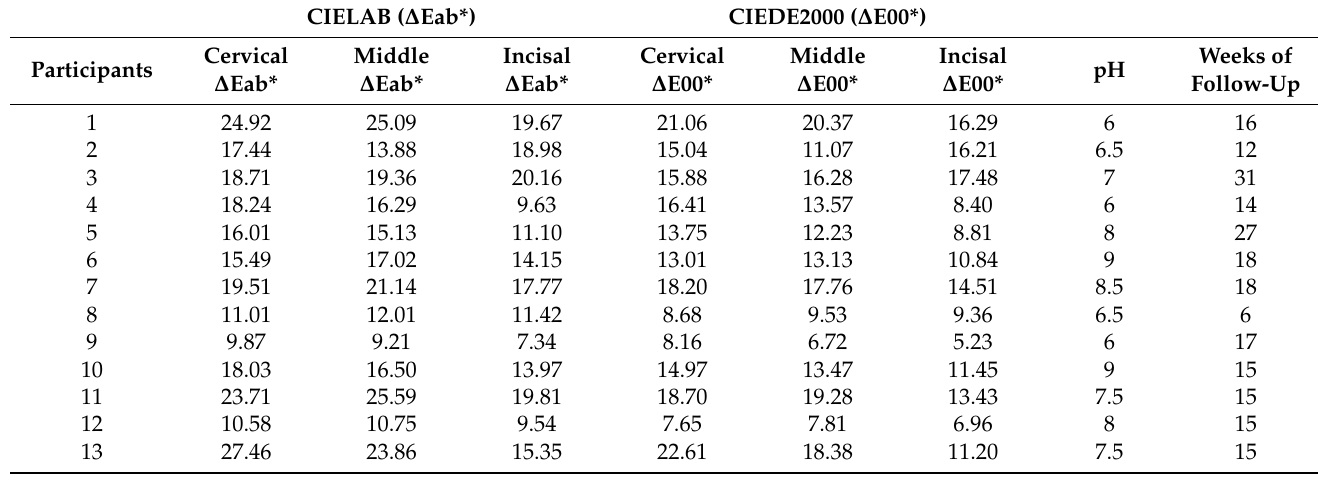
Table 1. Colour differences, according to the Euclidean and CIEDE2000 formulae, in the three thirds of the upper central incisor.